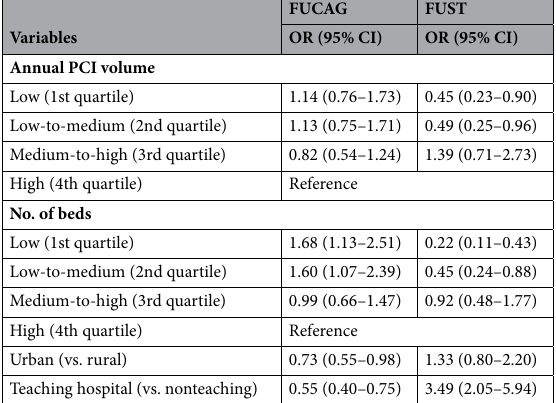
ROC curve with general institutional characteristics